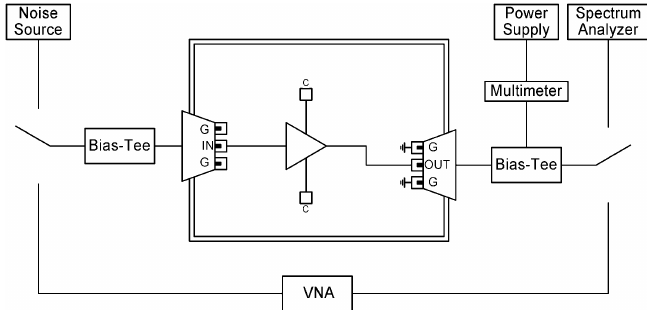
Fig. 2. Experimental setup for amplifier performance measurements.